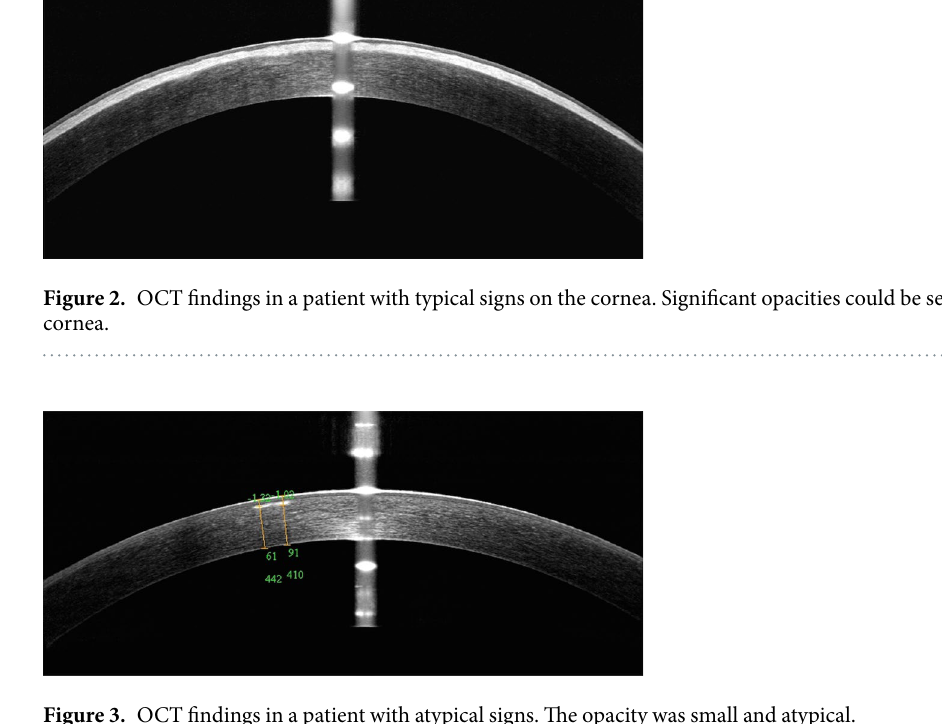
Figure 3. OCT findings in a patient with atypical signs. The opacity was small and